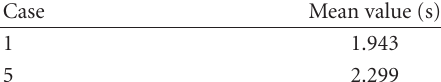
of an approximated residence time of the solid particles.